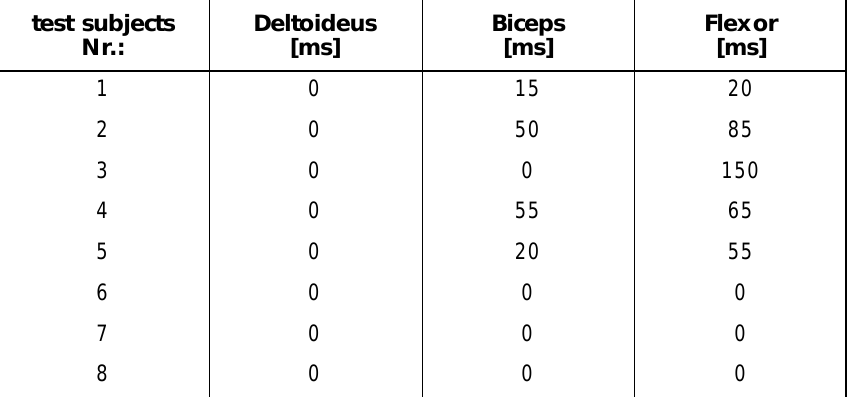
Table 5: Innervation sequences in anteversion of healthy subjects.